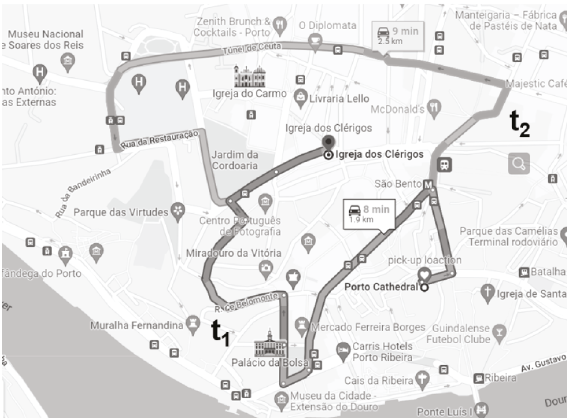
Figure 1: An illustration of trips traversing from Porto cathedral to Cl´erigos